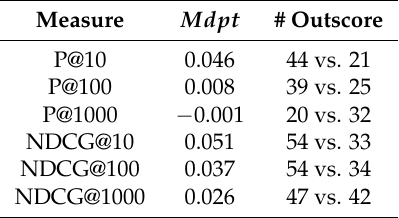
Table 23. T2: Porter/DirichletLM+QE+RF run vs. RR fusion of models using NoPorterNoStop